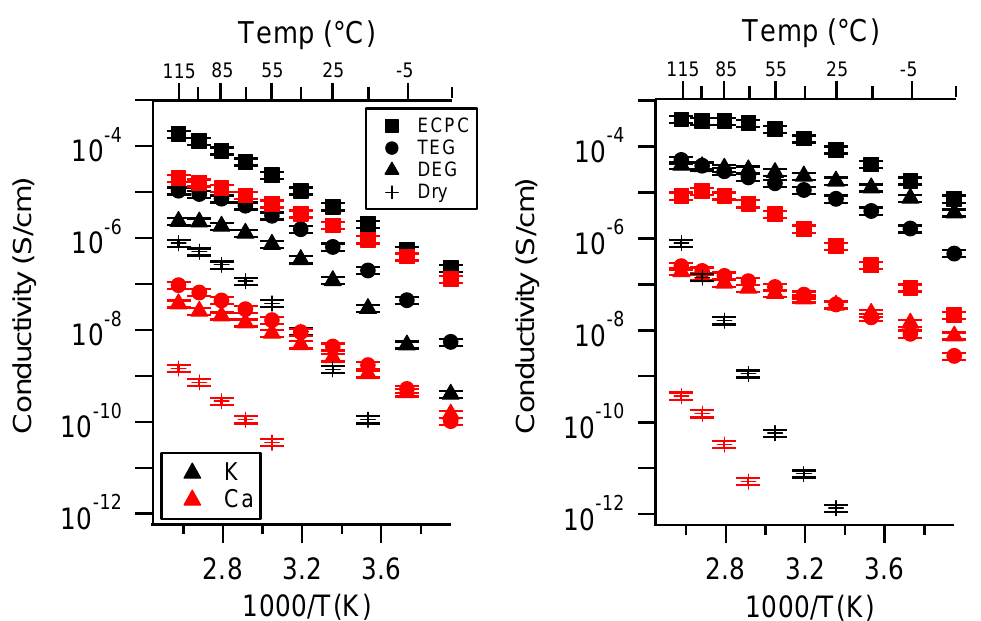
Figure A24. (reproduced from main text) Conductivity as a function of swelling state for PEGDMA1000_low_SSM (left) and PTHFDA1000_low_STFSIM (right) SIPEs. Temperatures ranged from − 20 °C to 115 °C. Note that there may be a non ‐ negligible fraction of electronic conductivity in conditions where conductivity of less than 10 − 9 S/cm is reported.